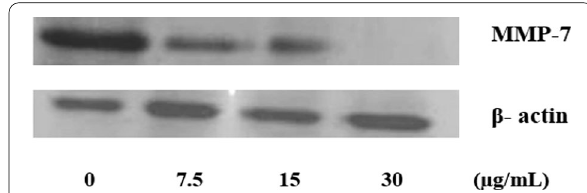
Fig. 9 Western blot analysis shows a clear decrease in the MMP-7 expressionin DLD-1 cells treated with plant extract fraction in a dose dependent